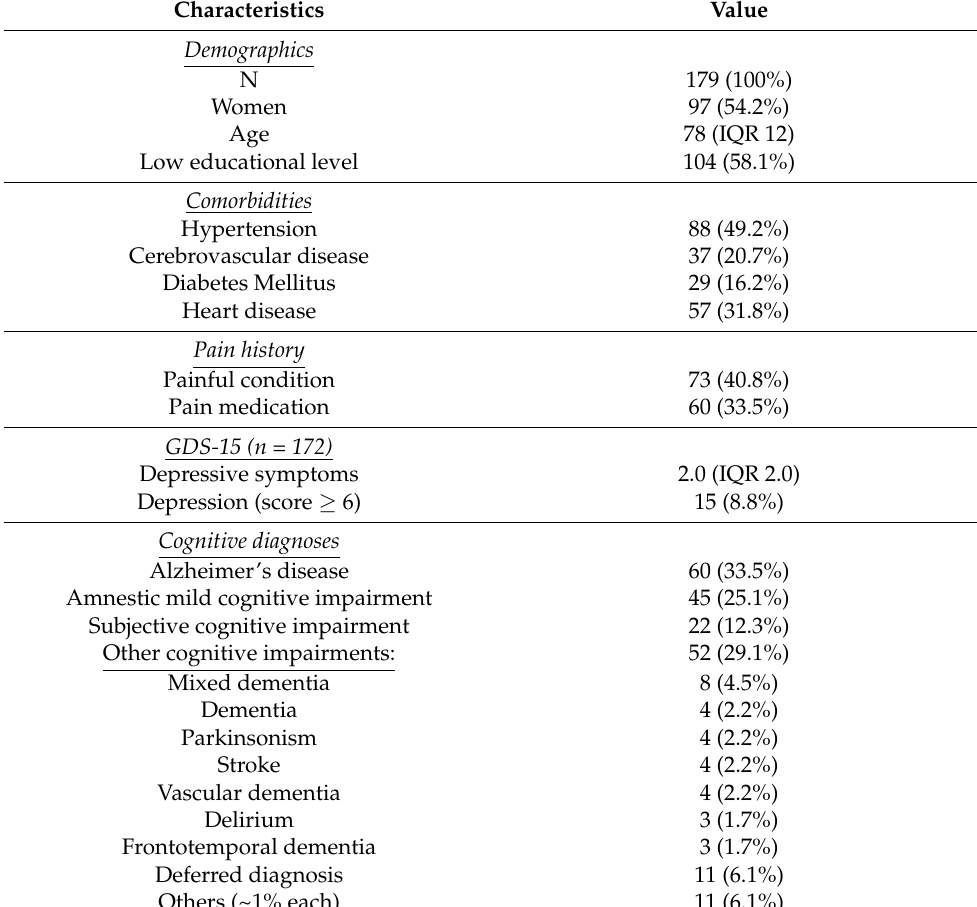
Table 1. Characteristics of the study